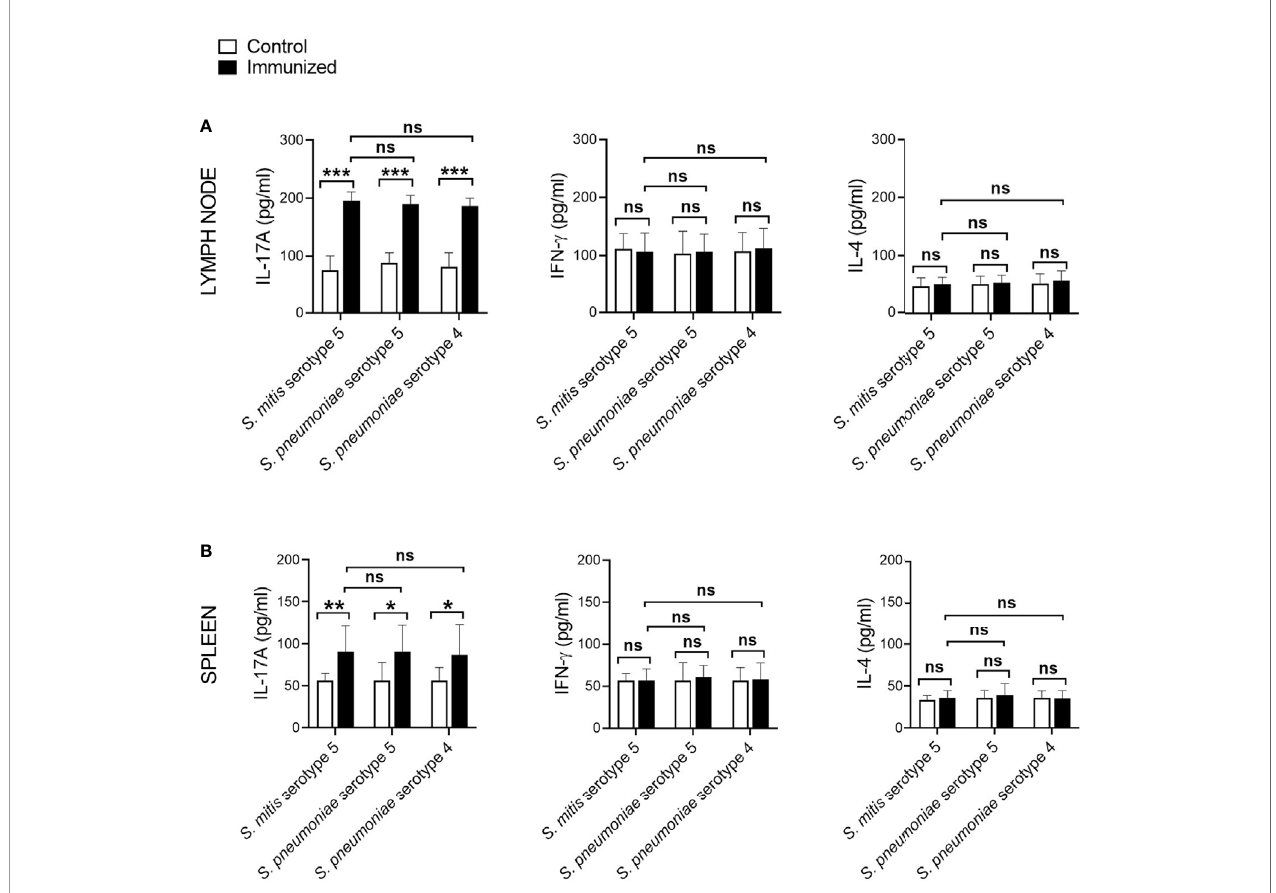
FIGURE 4 | Antigen-speci fi c cytokine production by the lymph node cells and splenocytes following immunization. The mediastinal lymph node cells and splenocytes from the S. mitis serotype 5-immunized or control mice subjected to pneumococcal challenge were restimulated with killed S. mitis serotype 5, S. pneumoniae 5 or S. pneumoniae 4 for 72 hours, and the cytokine levels (IL-17A, IFN- g , and IL-4) in the culture of (A) lymph node cells and (B) splenocytes were measured by ELISA. Data are shown as mean ± SD and pooled from the results of two independent experiments with 4 mice in each group. *p<0.05; **p<0.01; ***p<0.001. Unpaired student ’ s t test. ns, not signi fi